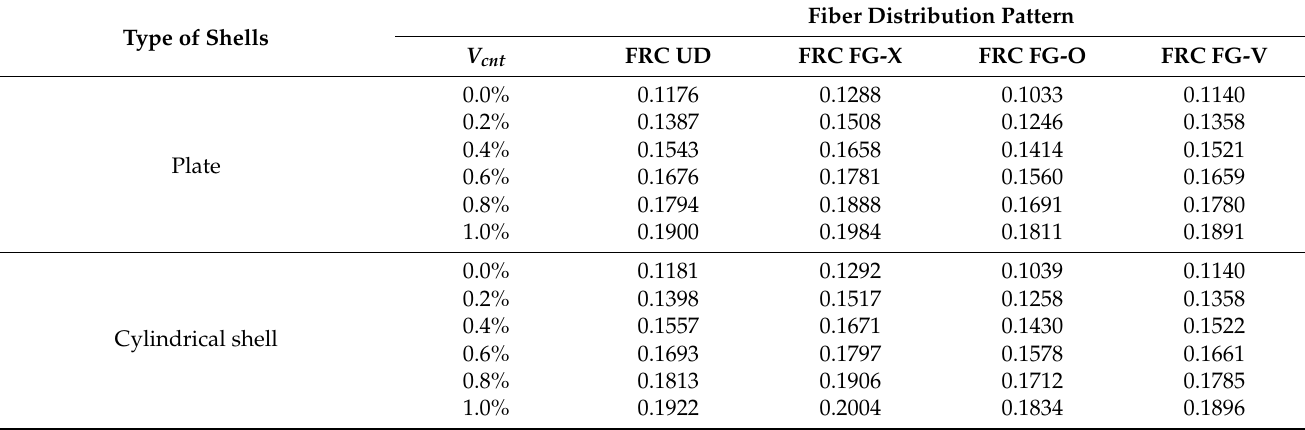
Table 7. The effect of the volume fraction of CNTs and fiber distribution patterns on the